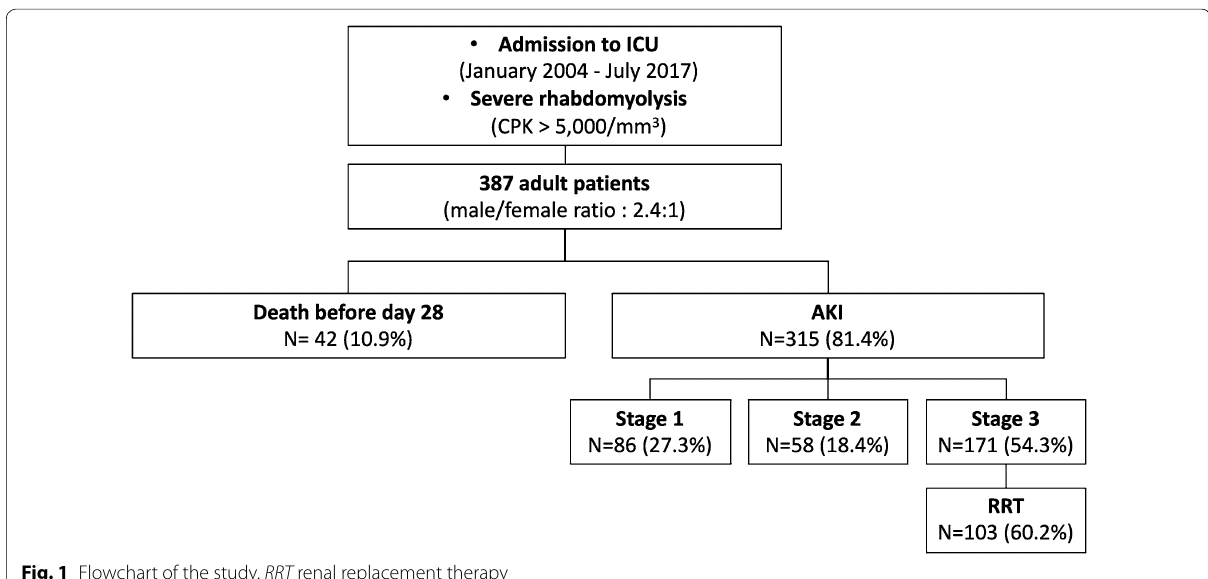
Fig. 1 Flowchart of the study. RRT renal replacement